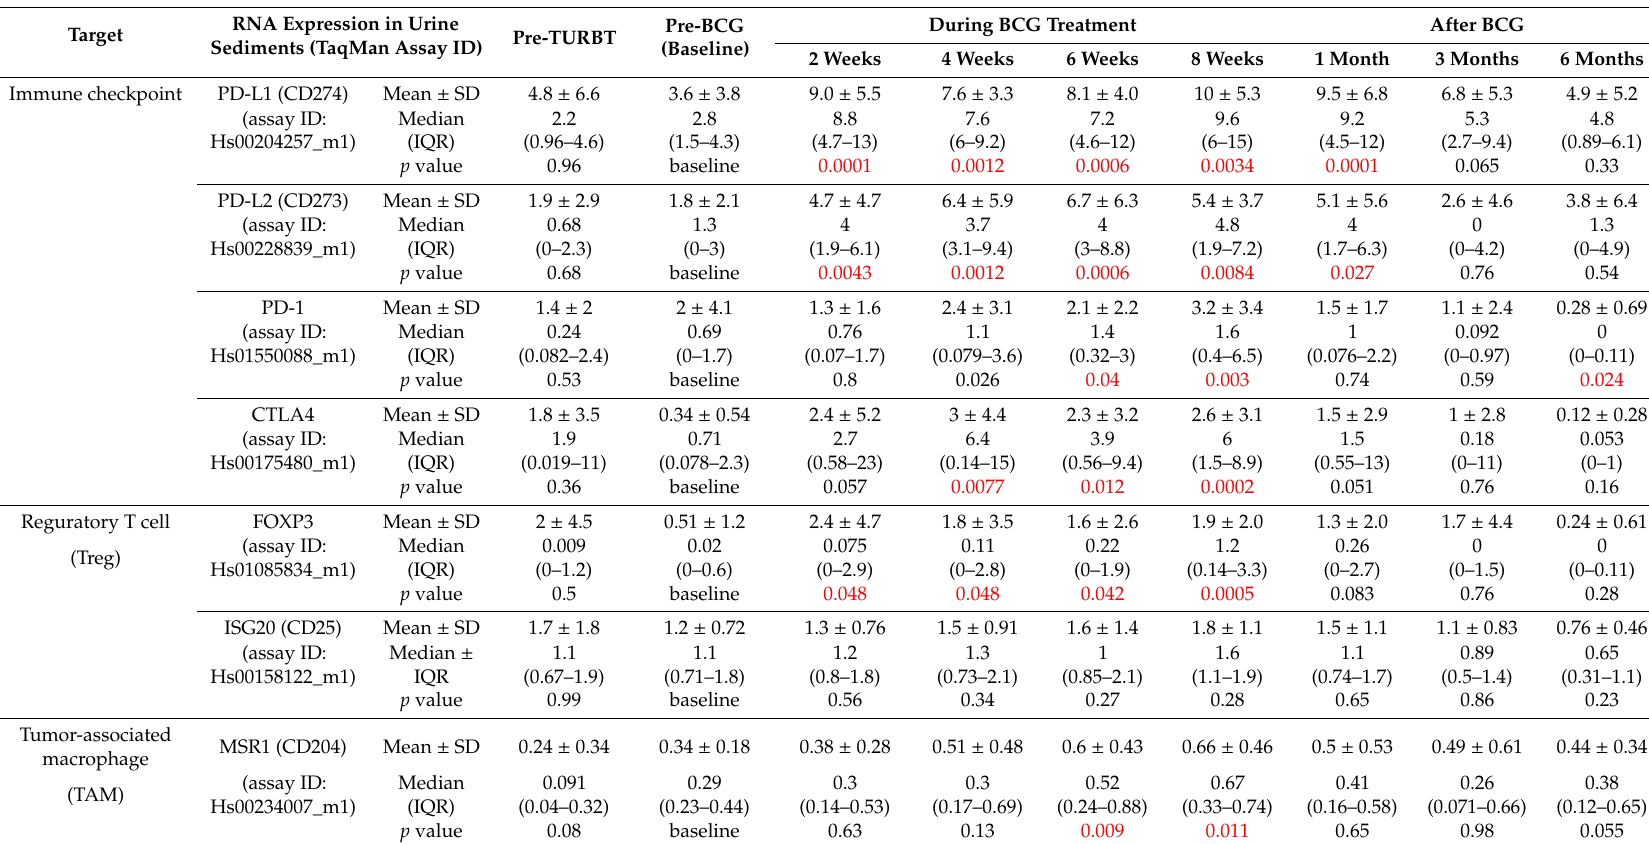
Table 3. Time-course changes in mRNA expression of immune cell markers in urine sediments before, during, and after intravesical BCG. Target Immune